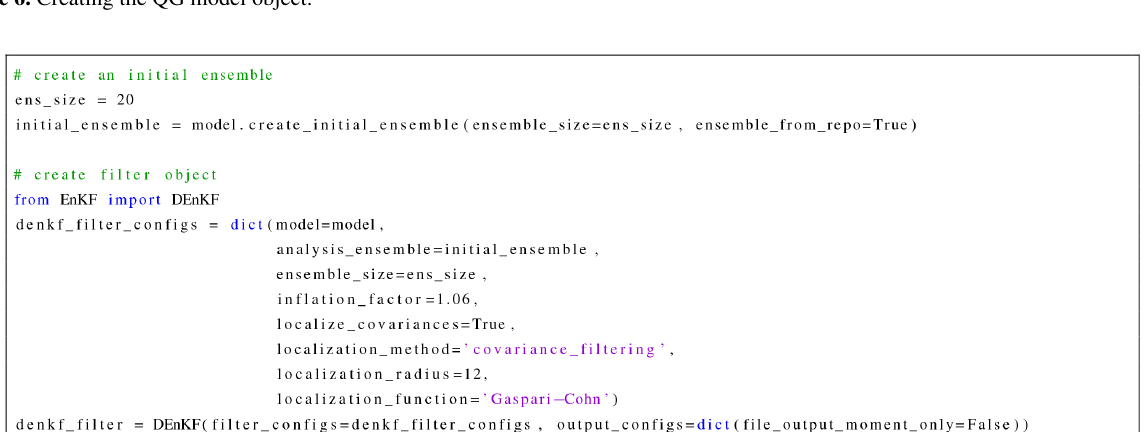
Figure 7. Creating a DEnKF filtering